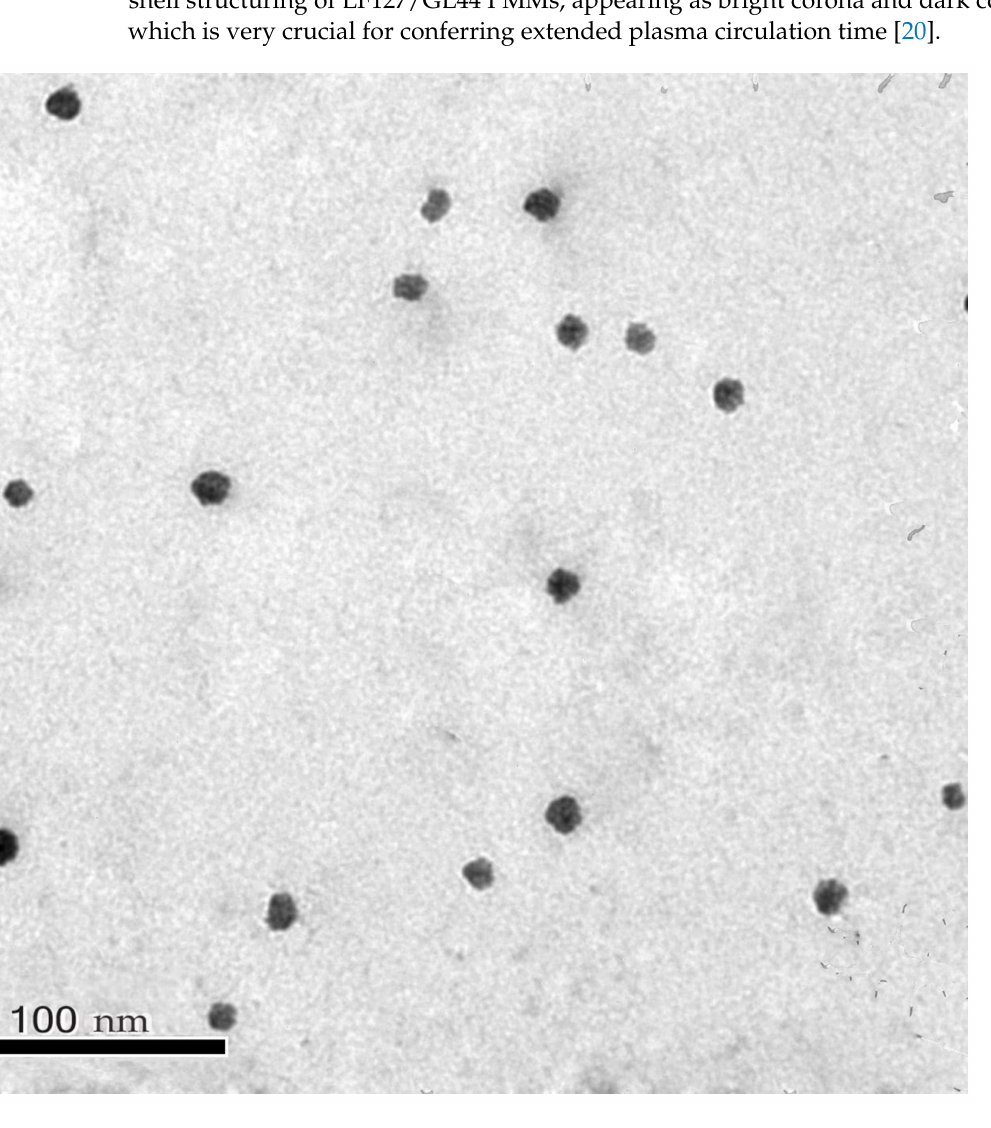
Figure 3. Transmission electron photomicrograph of the optimized